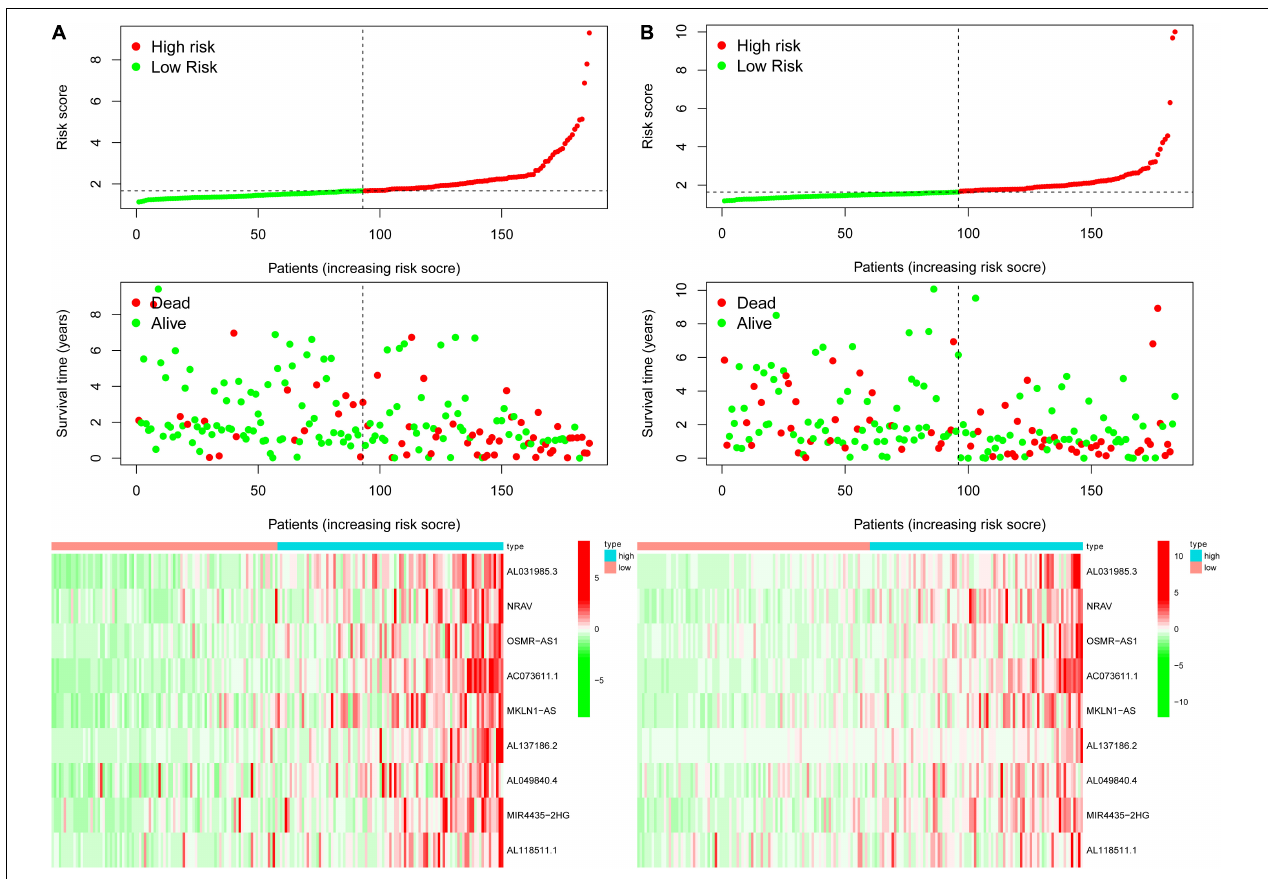
FIGURE 6 | The risk survival status chart of TCGA-HCC cohort. (A) The risk survival status plot of the patient in the training cohort, and the number of patients who died increased with the increase in patient risk score. (B) The risk survival status plot of the patient in the testing set.